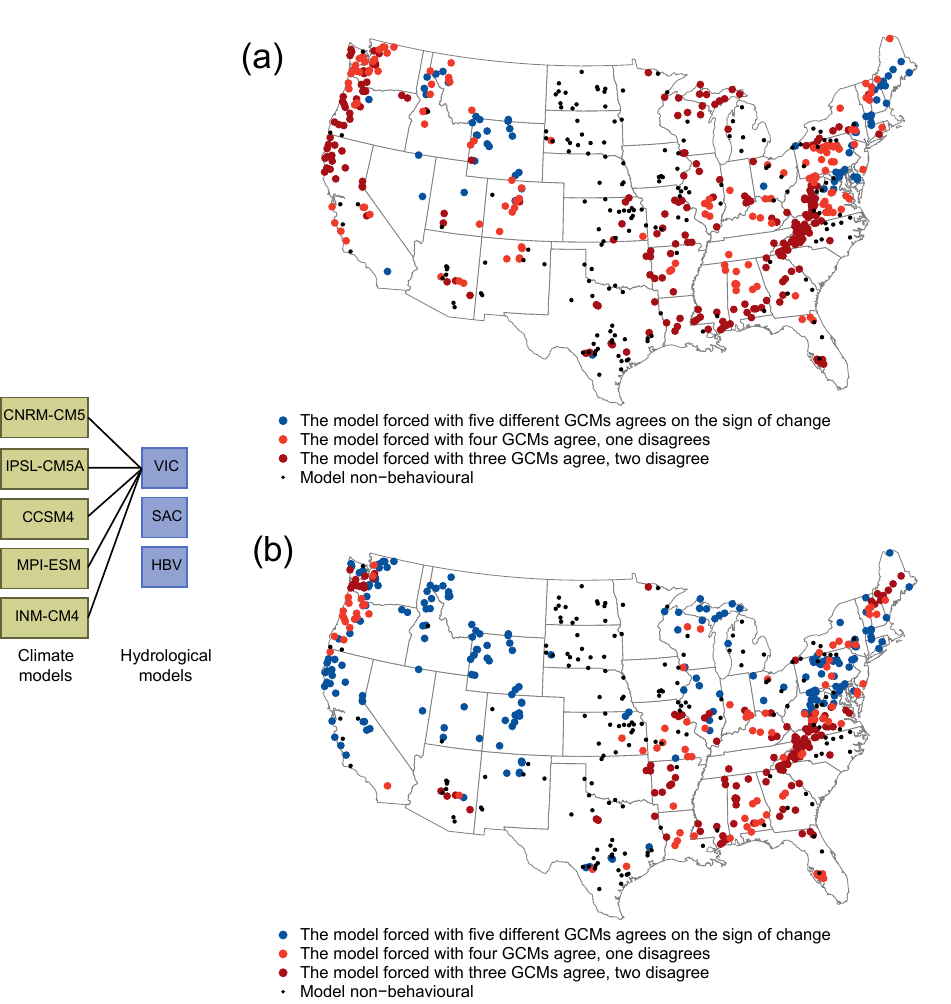
Figure 6. Distribution of uncertainty in the sign of change over the contiguous US when different GCMs are used to force a hydrological model. Left panel: combination of climate model and hydrologic model (VIC: Variable Infiltration Capacity model; SAC: Sacramento Soil Moisture Accounting model; HBV: Hydrologiska Byråns Vattenbalansavdelning model) for which the results are displayed. (a, b) Agreement on the sign of the ensemble mean change when the same hydrologic model (VIC) is forced with data from five different